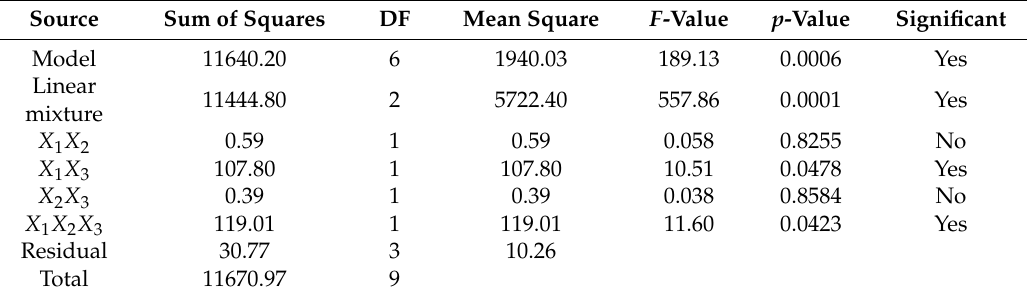
Table 8. ANOVA results for retardation time ( τ